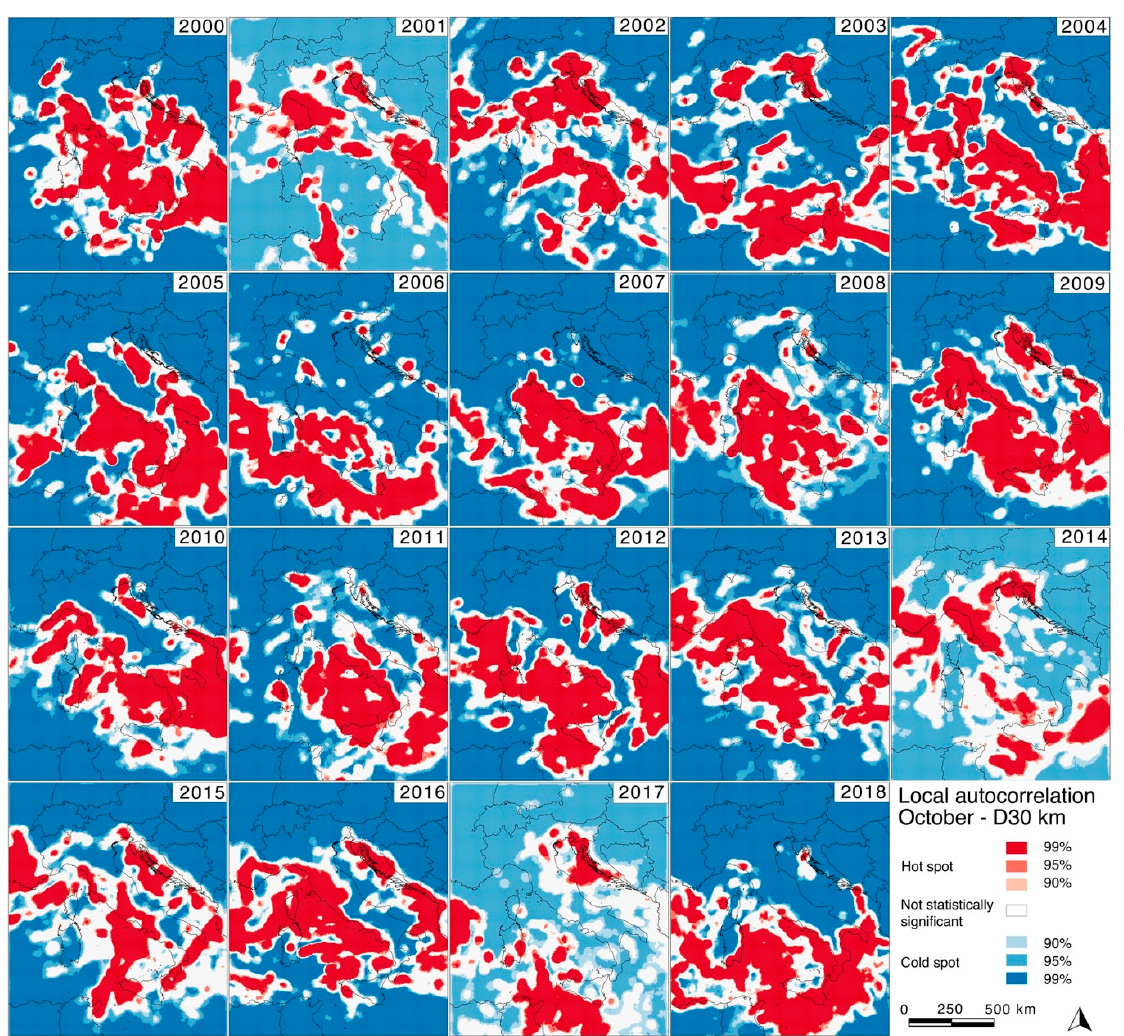
Figure 10. Local autocorrelation at a distance of D = 30 km for October in the 2000–2018 period at 90%, 95%, and 99% confidence levels.